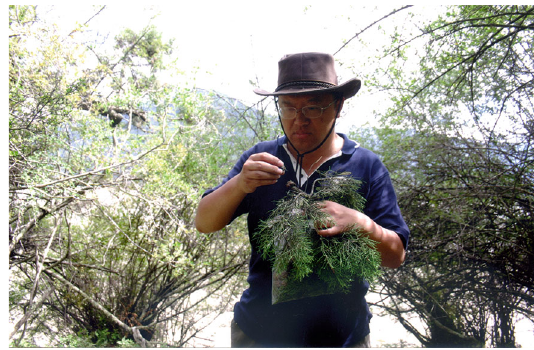
Figure 3. Prof. Zhong is working on collection and investigation of plant